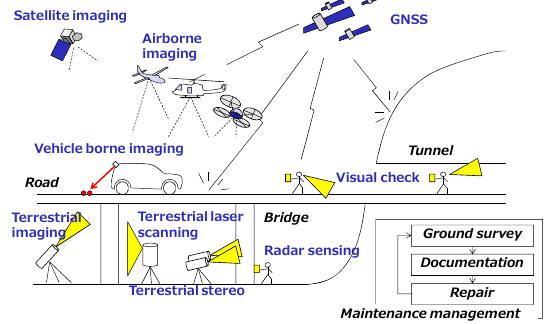
Figure 1. Ground-based infrastructure inspection Figure 2. Infrastructure